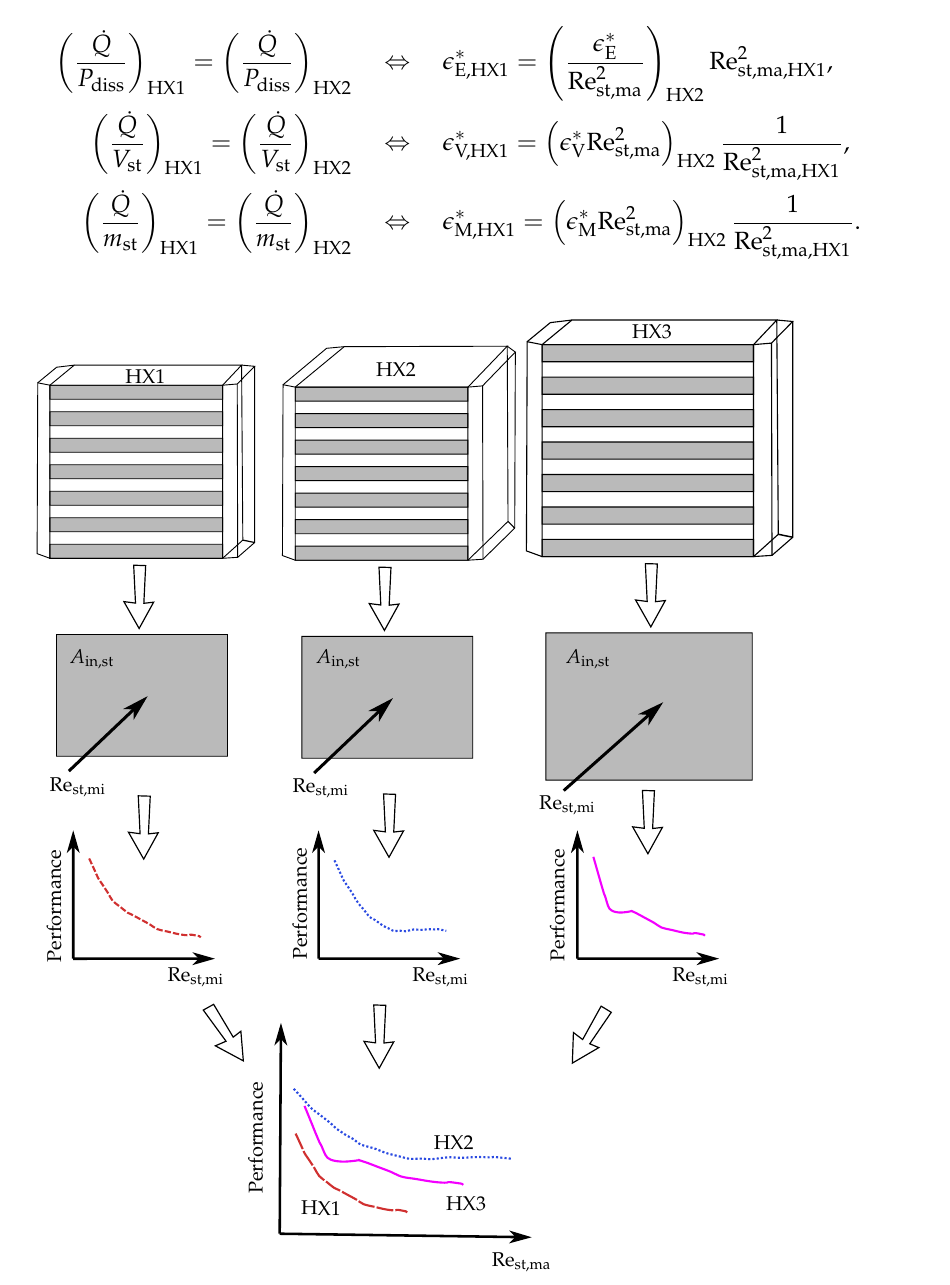
Figure 2. Scheme of a performance visualization generation for different types of heat transfer enhancements in differently sized heat